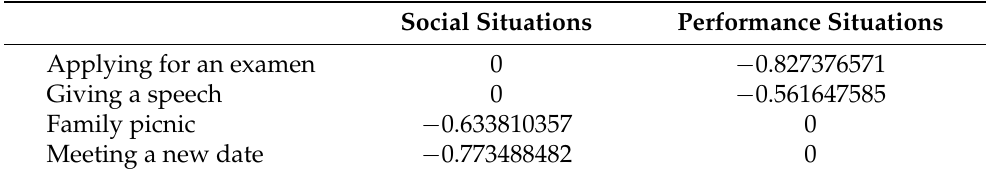
Table 10. Loading matrix C with the DisjointTuckerALS algorithm for behavioral level data.